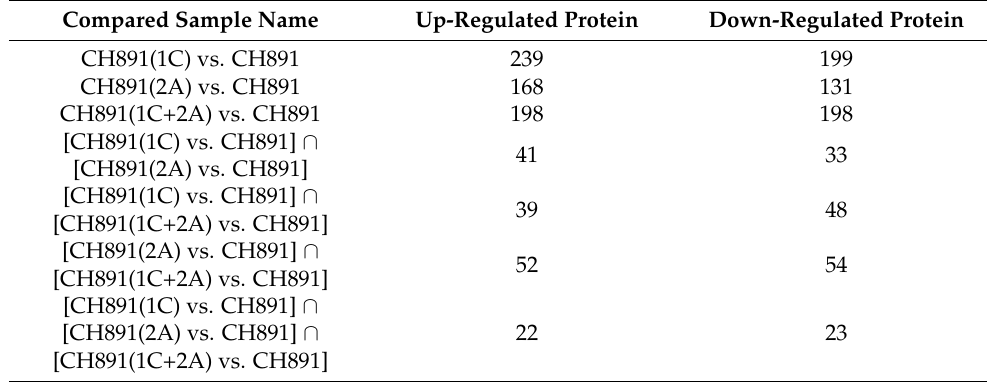
Figure 6. ( a ) Correlation coefficients and ( b ) box plots of protein expression levels of leaf samples of three transgenic lines and their recurrent parent collected at the heading stage. Each line was represented by three biological replicates. RSD (relative standard deviation), boxplot of RSD of quantitative protein values between repeated samples. The smaller the overall RSD value, the better the quantitative repeatability. Table 1. Summary of the number of differentially expressed proteins (DEPs) in three transgenic lines [CH891(1C), CH891(2A), and CH891(1C+2A)] as compared with their recurrent parent (CH891). The number of DEPs was determined using a threshold ratio of 1.5-fold between those proteins expressed in each transgenic line to those expressed in the recurrent parent. Upregulated proteins had a ratio of >1.5-fold and downregulated proteins had a ratio of <1/1.5-fold.